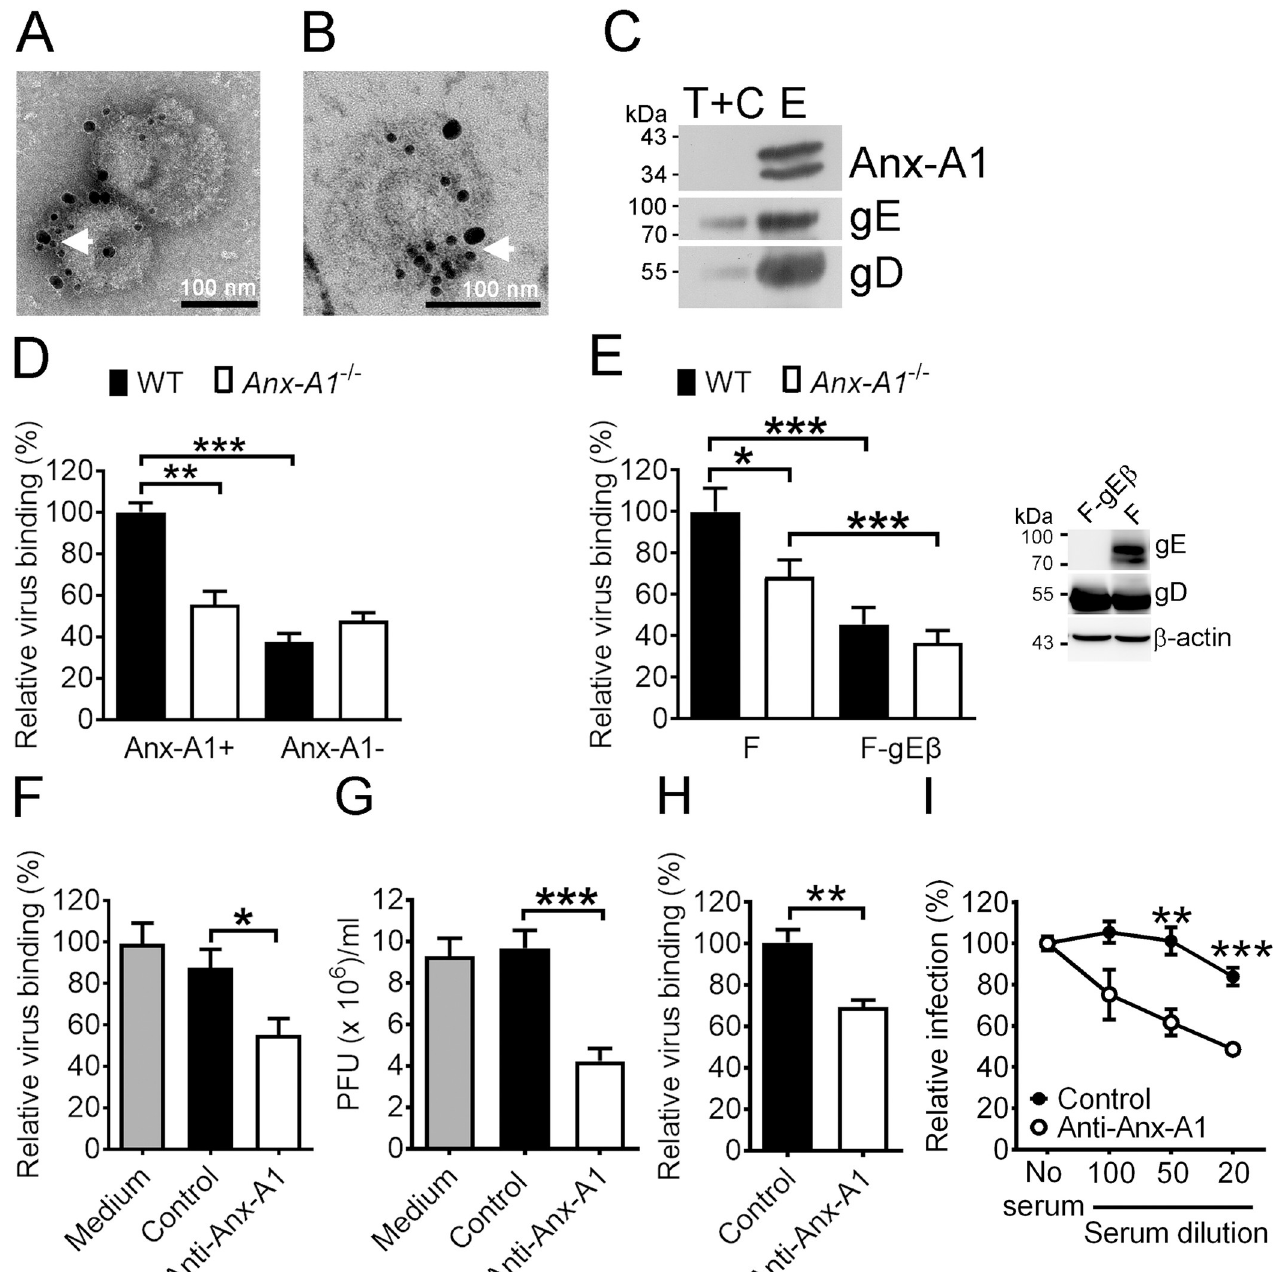
Fig 4. Anx-A1 on the HSV-1 envelope enhances virus binding to the cell surface. Representative images of transmission electron microscopy of Anx-A1 and gE on purified HSV-1 virions ( A ) and ultrathin sections of HSV-1 virions ( B ) are shown. The Abs against Anx-A1 or gE were labeled with gold particles of 18 and 10 nm, respectively. The arrows represent the Anx-A1-gE interaction. ( C ) Representative western blots of Anx-A1, gE, and gD in the tegument and capsid (T+C) and envelope (E) fractions of purified HSV-1 are shown. ( D ) The levels Anx-A1-positive (Anx-A1+) or Anx-A1-negative (Anx-A1-) HSV-1 binding on WT or Anx-A1 -/- MEFs are shown. ( E ) The representative western blots of indicated proteins in lysates of Vero cells infected with indicated HSV-1 strains at 16 hpi (right panel) and the levels of strain F or F-gE β binding to WT or Anx-A1 -/- MEFs (left panel) are shown. The levels of virus binding ( F ) and viral yields at 24 hpi ( G ) of WT MEFs treated without (medium) or with control or anti-Anx-A1 serum (at 1:500 dilution) are shown. ( H ) The levels of HSV-1 binding to N18 cells treated with control or anti-Anx-A1 serum (at 1:100 dilution) are shown. ( I ) The level of GFP-positive N18 cells treated with the indicated dilutions of control or anti-Anx-A1 serum and infected with KOS-GFP (MOI = 10) for 17 h are shown. The levels of Anx-A1-positive HSV-1 binding to WT MEFs or N18 cells treated with control serum and the percentage of GFP-positive N18 cells without treatment were set as 100%. Data show the mean + SEM of > 4 per group. � P < 0.05, �� P < 0.01, and ��� P < 0.001.